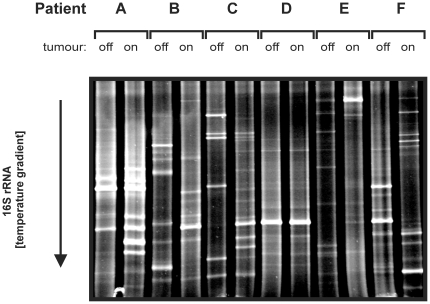
DGGE Fingerprinting of CRC Tissue and Non-malignant Adjacent
Mucosa.An internal fragment (∼450 bps) of the bacterial 16S rRNA gene was
amplified from colon tissue-extracted DNA by a broad-range PCR approach
after which these amplicon mixtures were applied to DGGE. Patient
characteristics can be found in Table 1; off,
non-malignant tissue; on, tumor tissue.